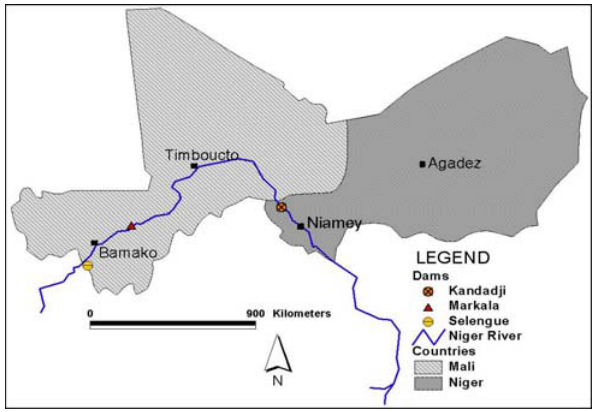
Figure 3: Location of Dams in Mali and Niger Republic Associated With Ecological